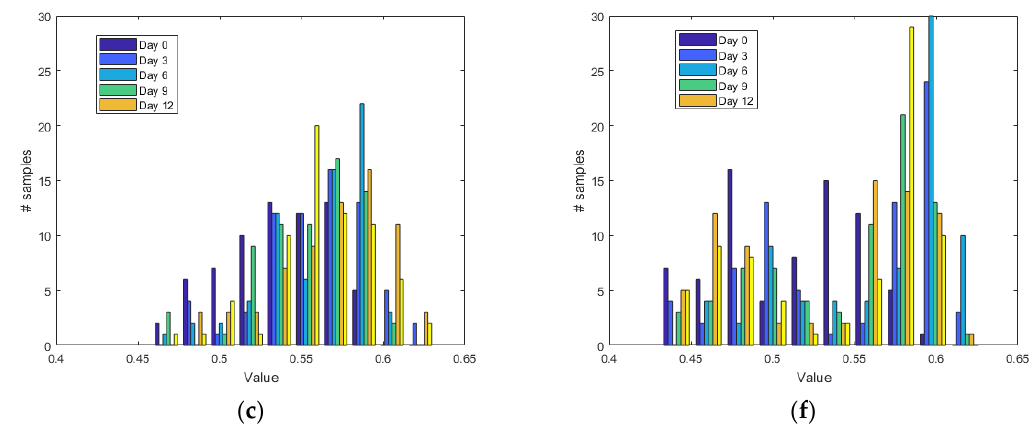
Figure 10. Histogram for a red apple for different days: Histogram of the hue ( a ), saturation ( b ) and value ( c ) parameters in the fridge. Histogram of the hue ( d ), saturation ( e ) and value ( f ) parameters at room temperature. Sensors 2019 , 19 , x 11 of 20